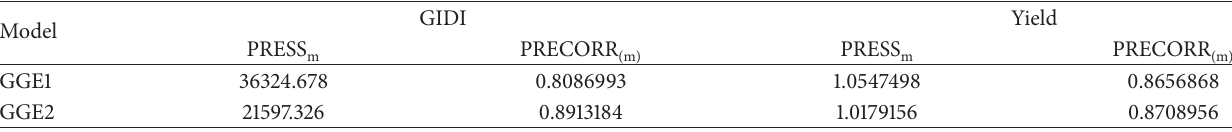
Table 2: Estimates obtained for PRESS (sum of squared prediction error) and PRECORR m GGE1 and GGE2 models (biplot with 1 and 2 principal components, resp.) for the GIDI and for yield (tonha − 1 ).